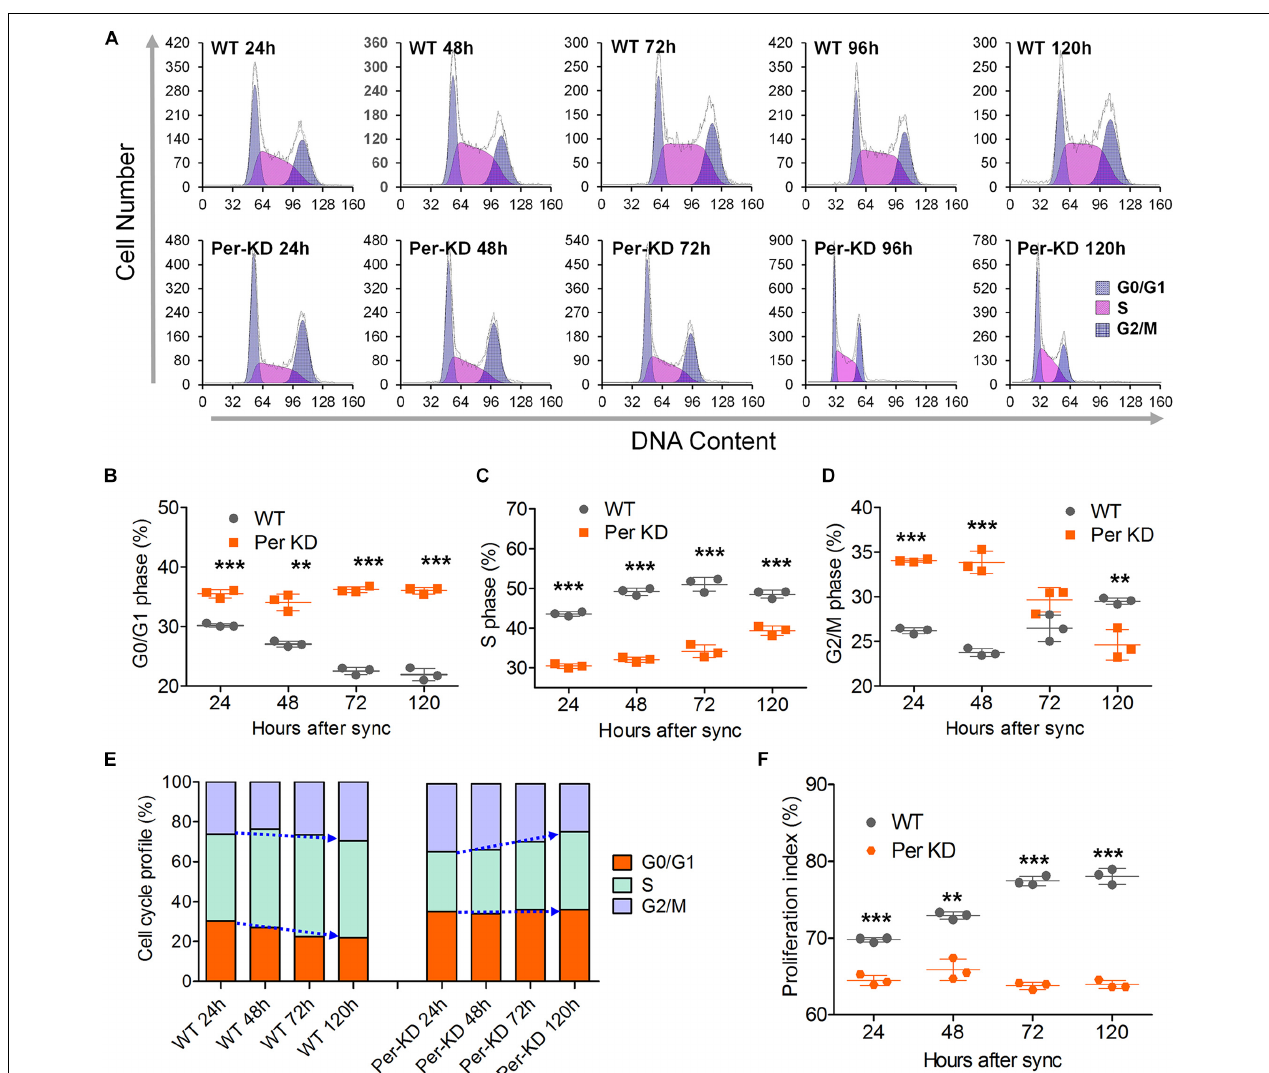
FIGURE 4 | Cell cycle changes induced by BmPer gene knockdown. WT and BmPer knockdown BmN cells (Per-KD) were assayed 24, 48, 72, and 120 h after synchronization. (A) PI-FCM (Propidium Iodide-flow cytometry) results. (B–D) Percentages of cells in G0/G1 phase, S phase and G 2 /M phase. (E) Cell cycle profile. (F) Proliferation index = (S+G 2 /M)/(G 0 /G 1 +S+G 2 /M) × 100%. ∗∗ p < 0.01, ∗∗∗ p < 0.001 ( n =